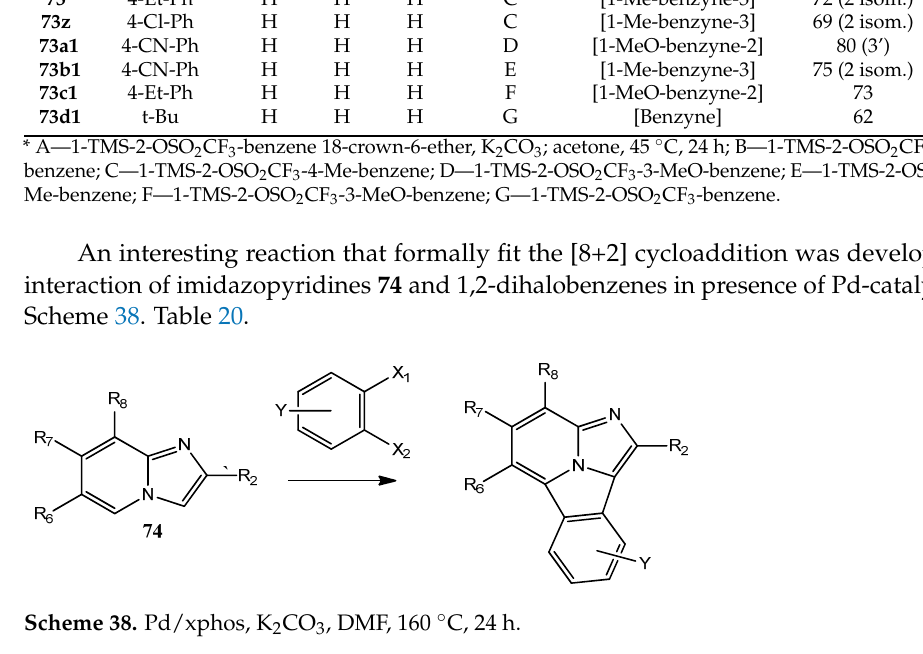
Table 20. Substituents and yields of reaction of imidazopyridines and 1,2-dihalobenzenes (Scheme 38).